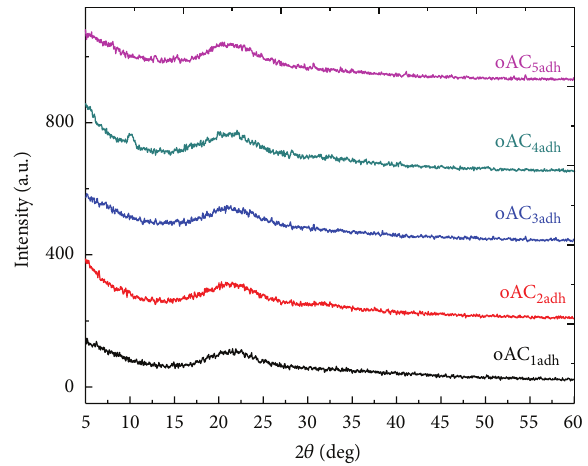
Figure 2: XRD patterns of alginate/k-carrageenan hydrogels films chemically cross-linked with adipic dihydrazide (oAC 1adh – oAC 5adh